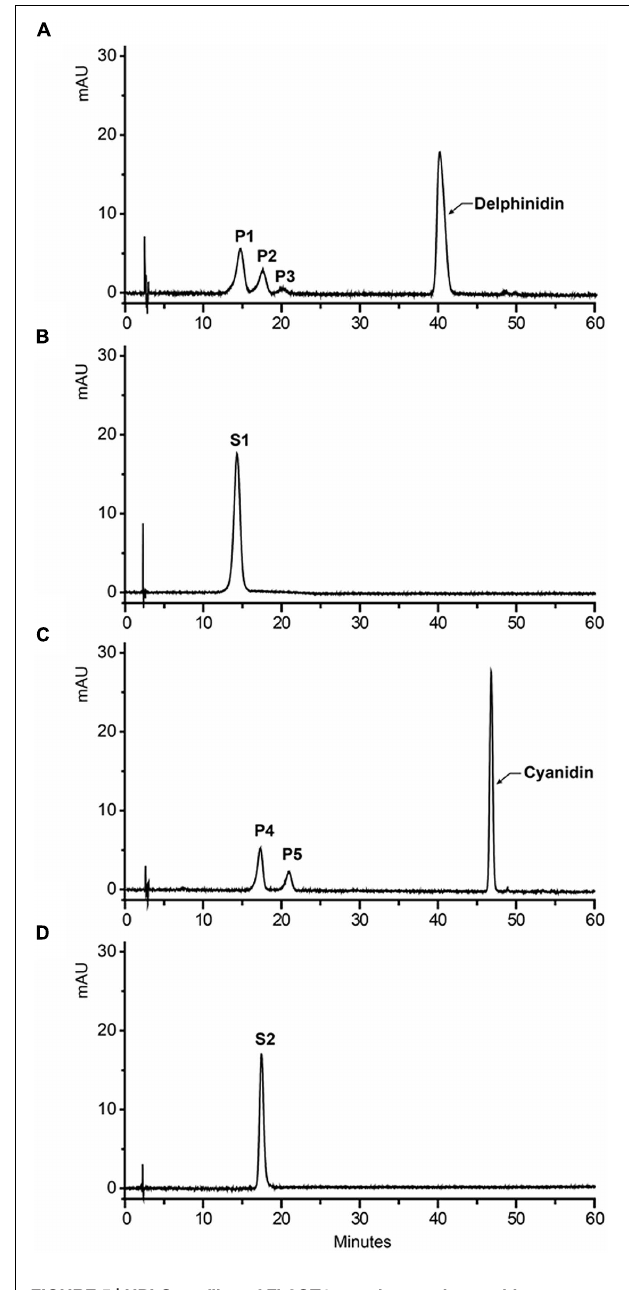
FIGURE 5 | HPLC profiles of Fh3GT1 reaction products with delphinidin/cyanidin and UDP-galactose. (A) Delphinidin